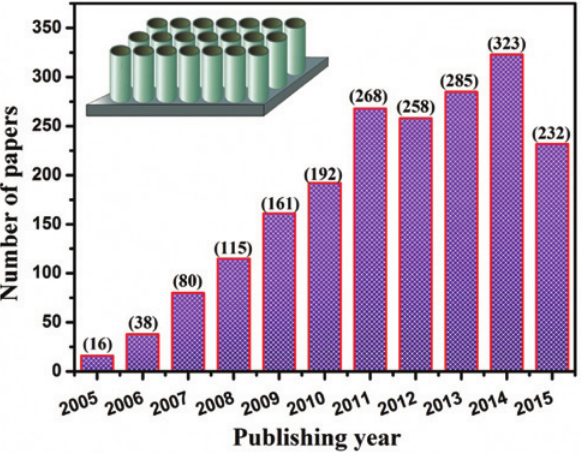
NTAs fabricated 2